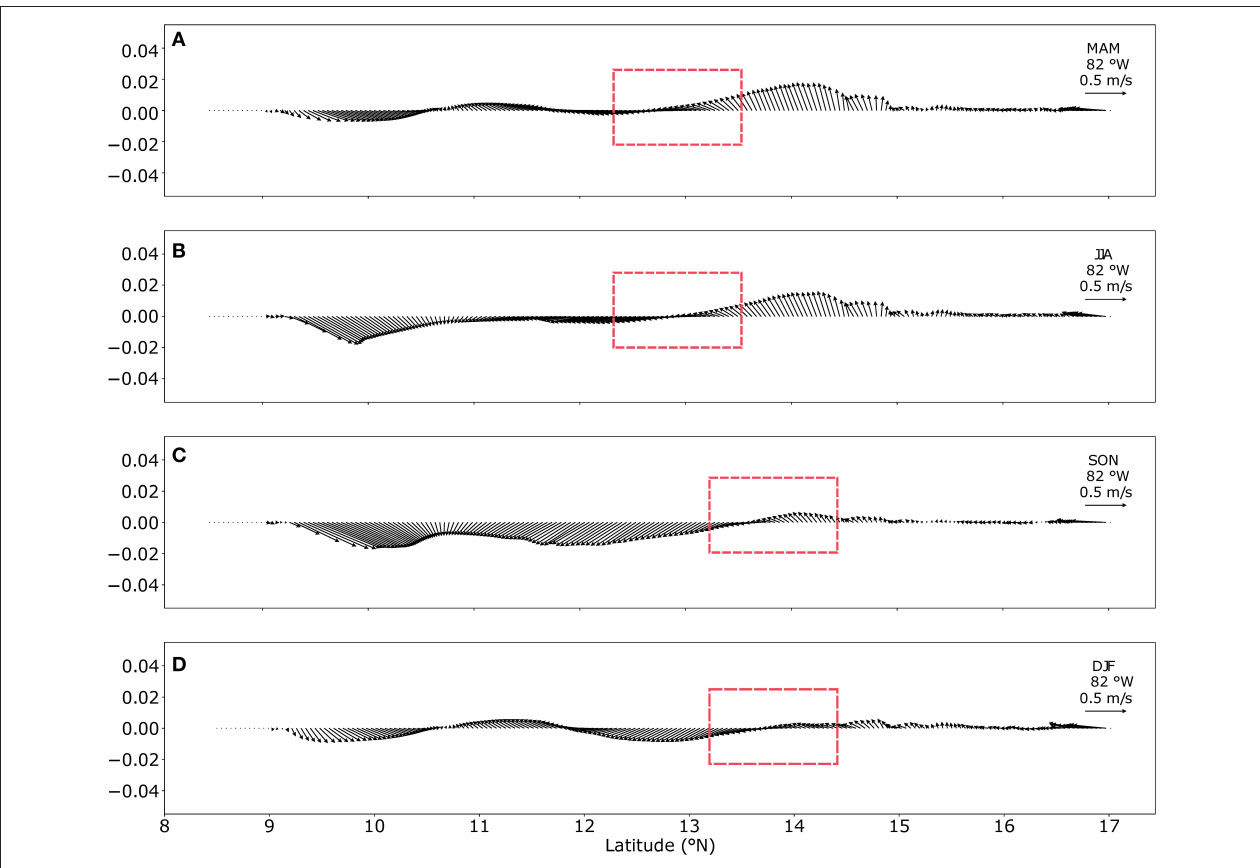
FIGURE 3 | Seasonal position of the CC bifurcation. Transects over 82 ◦ W during the climatological seasons (A) March–April–May, (B) June–July–August, (C) September–October–November, and (D) December–January–February. The arrows show the direction of the flow, and arrow length corresponds to current speed (magnitude).